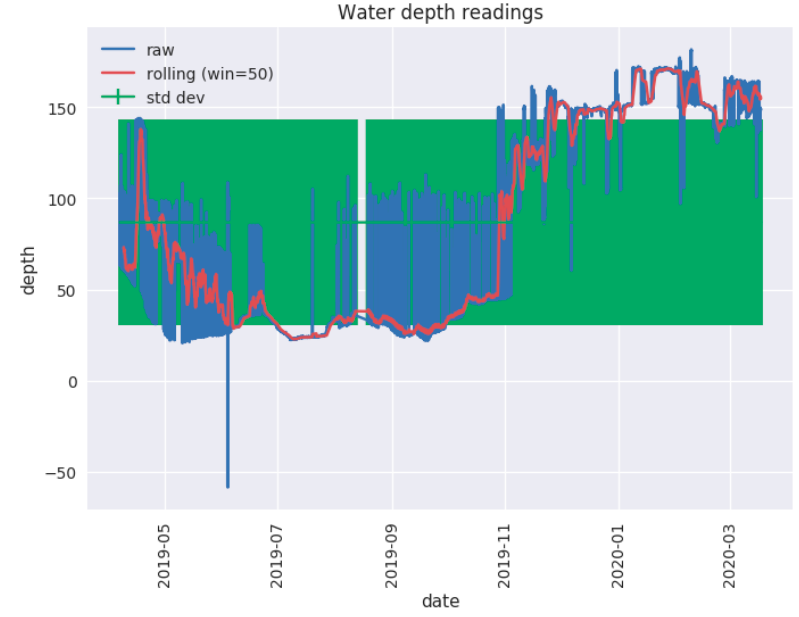
Figure 10. Sample dashboards to monitor resource utilization and overheads.